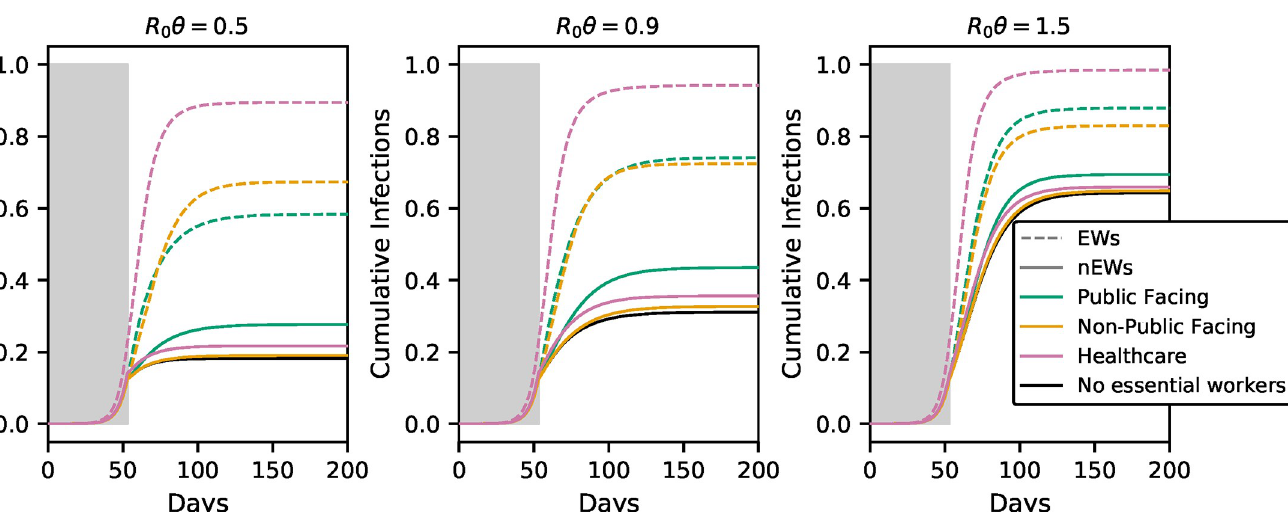
PLOS ONE | https://doi.org/10.1371/journal.pone.0255680 August 4,